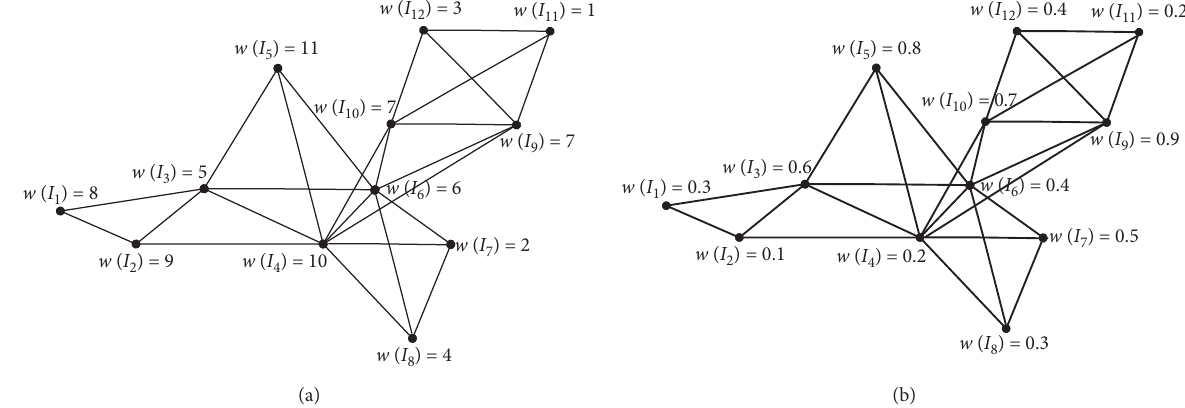
Figure 2: The weighted interval graphs (a) G